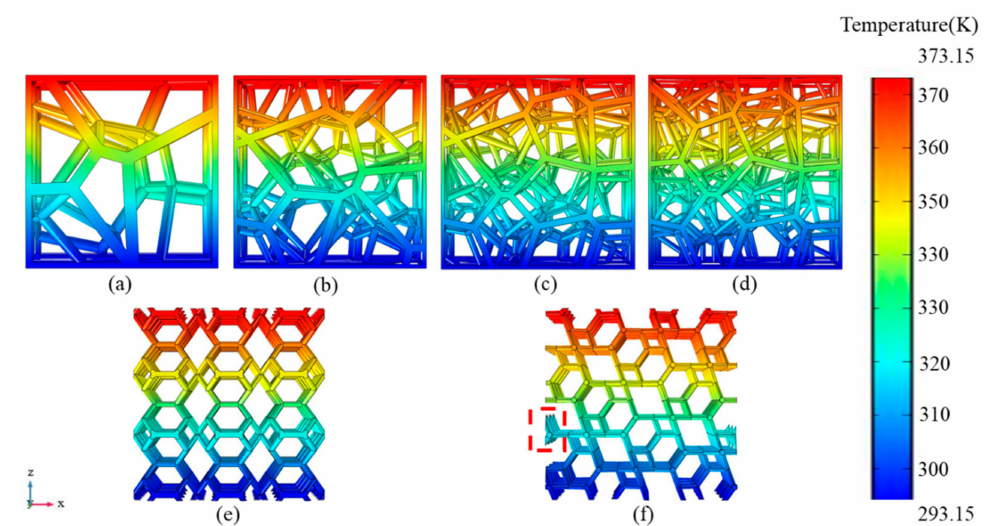
Figure 11. Temperature distribution of different structure types when the porosity is fixed at 95%: ( a ) RV10; ( b ) RV30; ( c ) RV50; ( d ) RV70; ( e ) KT; ( f )